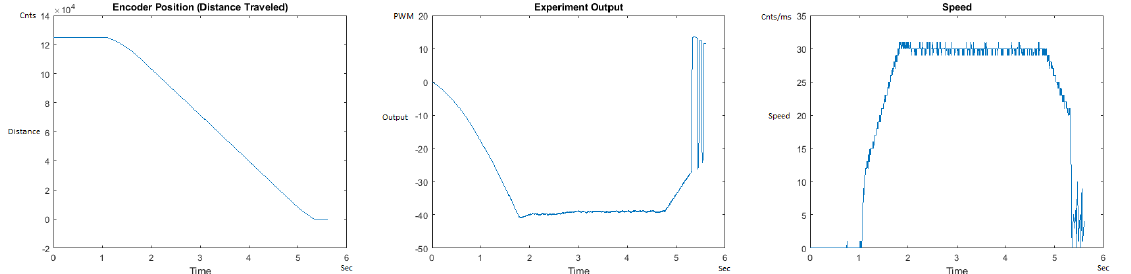
Figure 25. Encoder position, output and speed plots for PID++ DOWN operation— Vmax 30 cnts/ms, Adesired 0.040 cnts/ms 2 —10